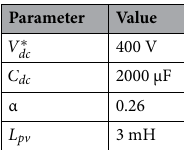
Table 4. The used parameters of the